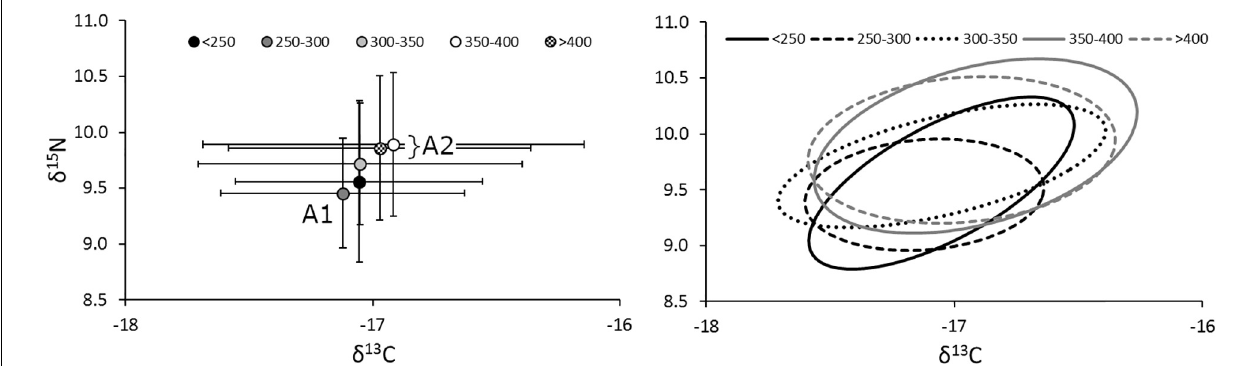
FIGURE 5 | (Left) Mean ( ± SE) isotope values and (right) isotopic niches (SEA c ) for lionfish in different size classes. Sample sizes for < 250-, 250– 300-, 300– 350-, 350– 400-, and > 400-mm size classes are 9, 57, 59, 41, and 36, respectively. The niche position of 250–300-mm lionfish (A1) was significantly different from the two largest size classes (A2; Hotelling’s T 2 test; p < 0.05), marginally different from the middle size class (300–350 mm; Hotelling’s T 2 test; p = 0.06), but not significantly different from the smallest ( < 250 mm; Hotelling’s T 2 test; p =